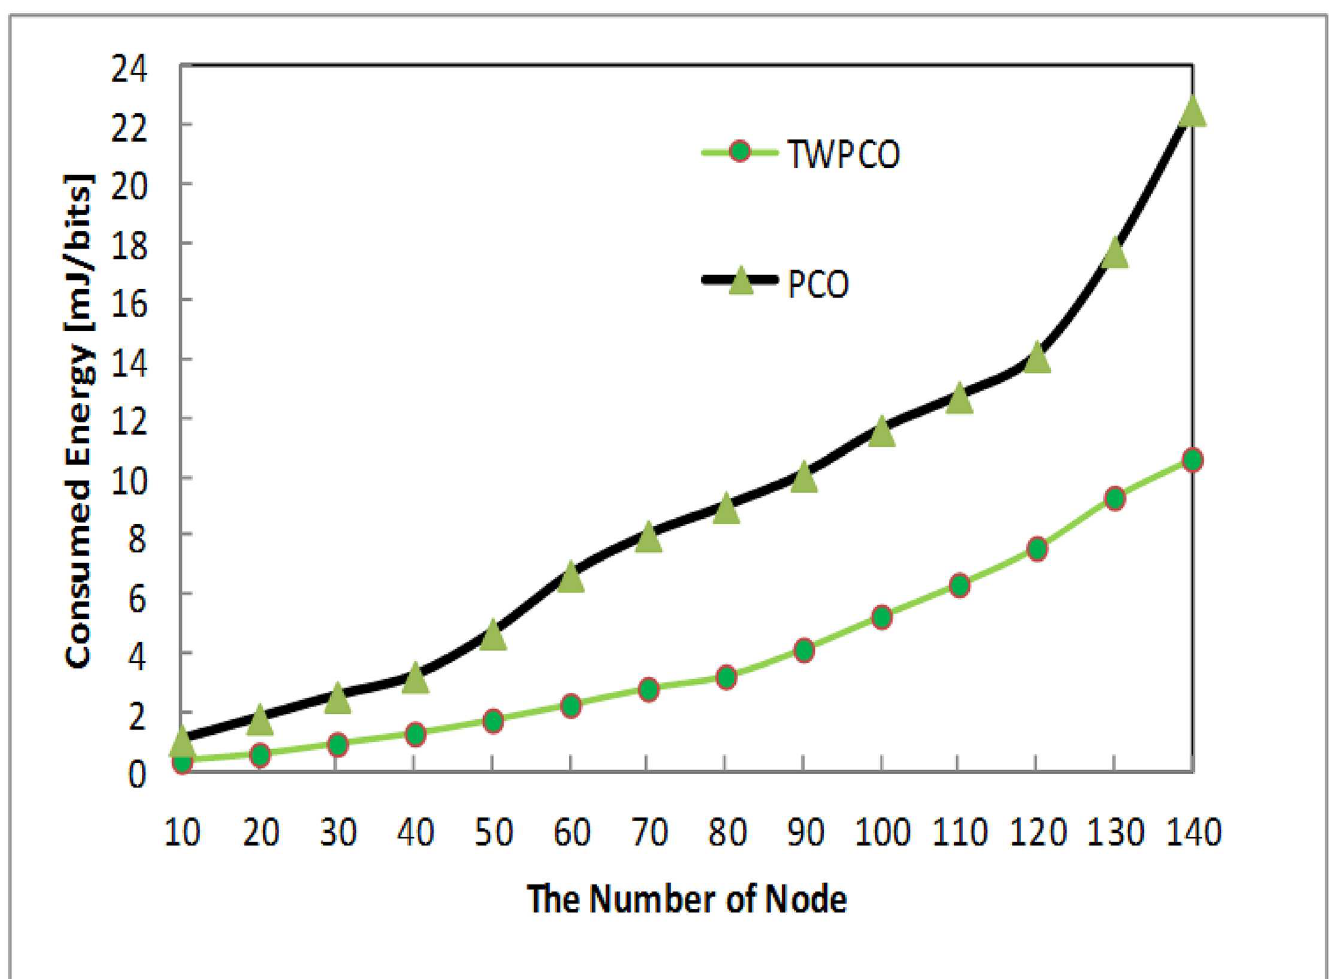
Fig 16. Energy efficiency ratio based on the number of nodes and the added number of sensor